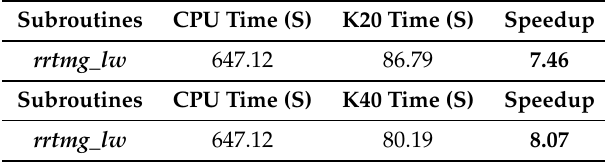
Table 6. Runtime and speedup of the G-RRTMG_LW with I/O transfer on one GPU, where the block size = 512 and ncol = 2048.